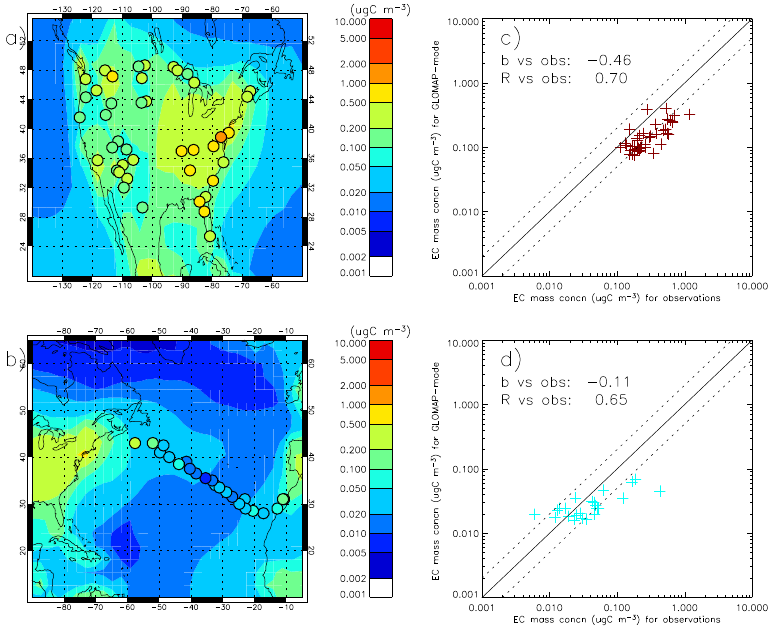
Fig. 6. Maps of simulated annual-mean black carbon concentration in the lowest model level (a) over Europe and (b) over the North Atlantic with surface observations from IMPROVE sites and cruise observations from Van Dingenen et al. (1995) respectively over-plotted. Scatter plots for the model (y-axis) compared to the observations (x-axis) are shown in panels (c) and (d) with b and R values also shown. IMPROVE observations are for the year 2000 with only sites where the height above sea-level is within 250m of that calculated for the lowest model level